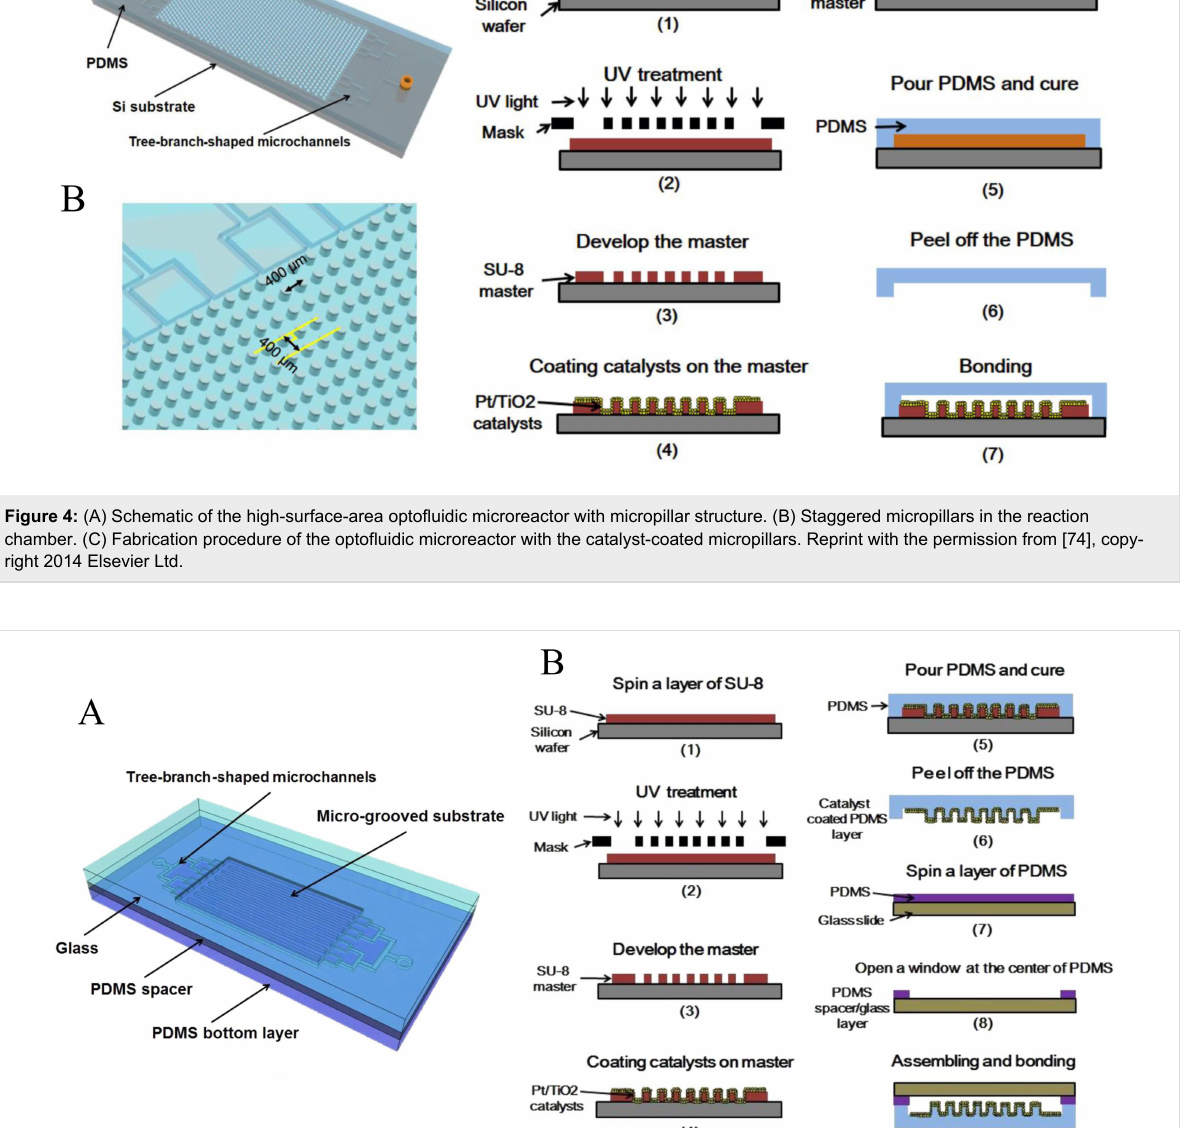
In addition to the PDMS/PMMA-based microchannel reactors, bacterium has been shown to be a good microreactor as